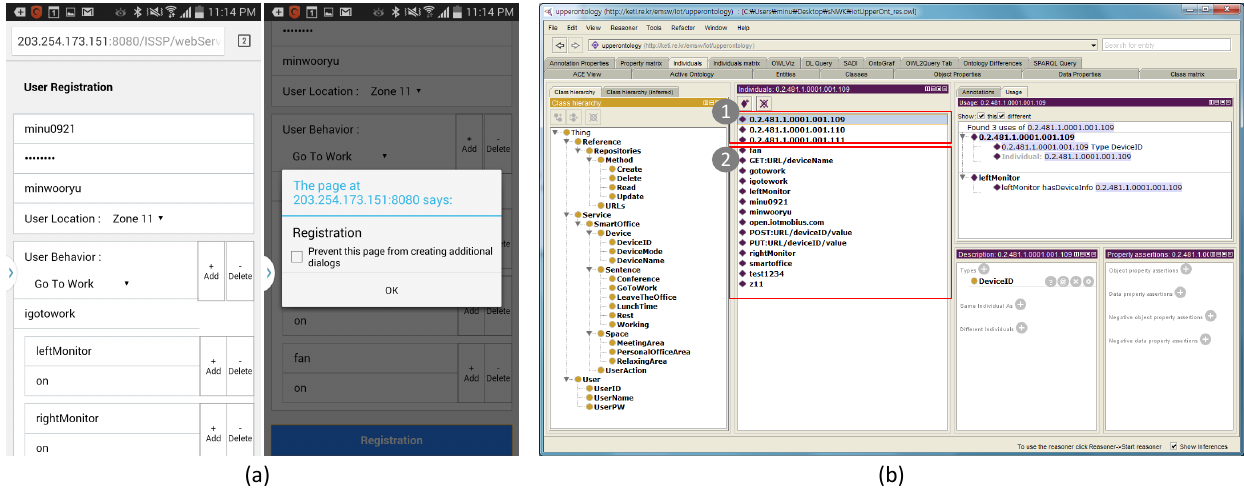
Figure 13. Results of ( a ) the web app operation (registration mode) and ( b ) individuals added in the